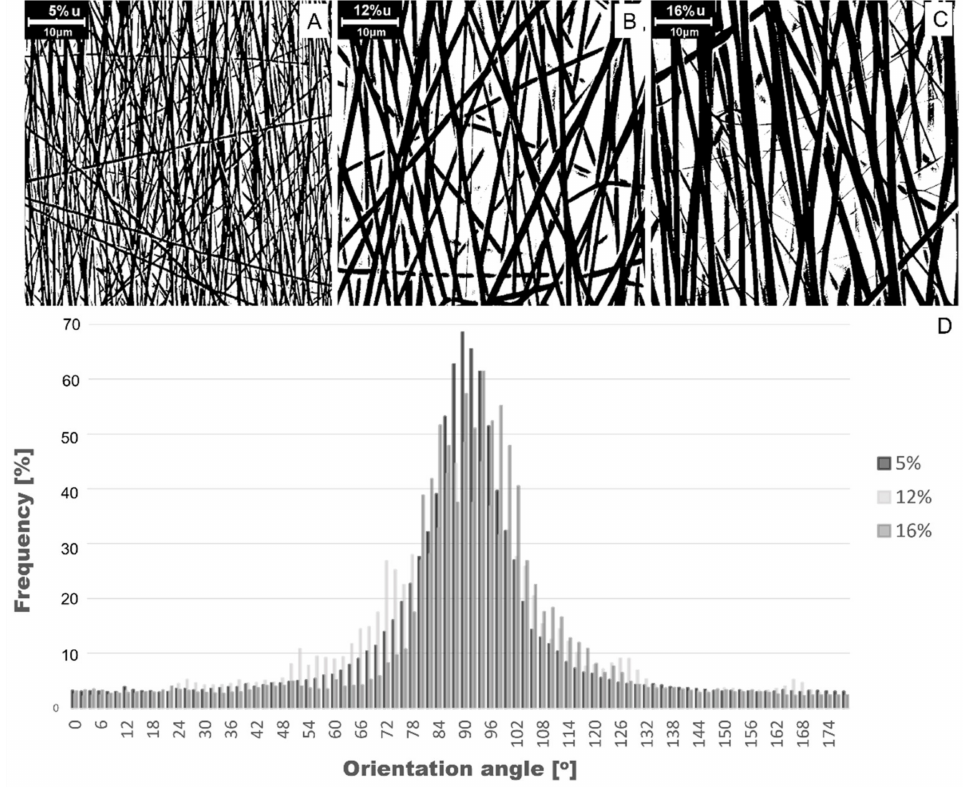
Figure 3. Morphology of the aligned fibrous structures obtained after binarization for SEM of